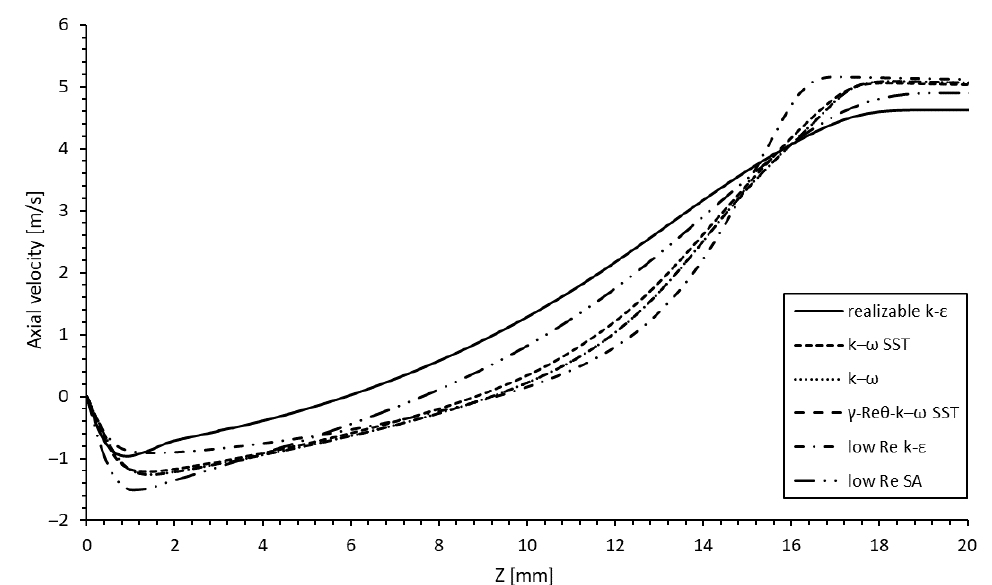
Figure 10. Simulated axial velocity magnitude at S4 for different turbulence models. The ordinate is clipped at Z =